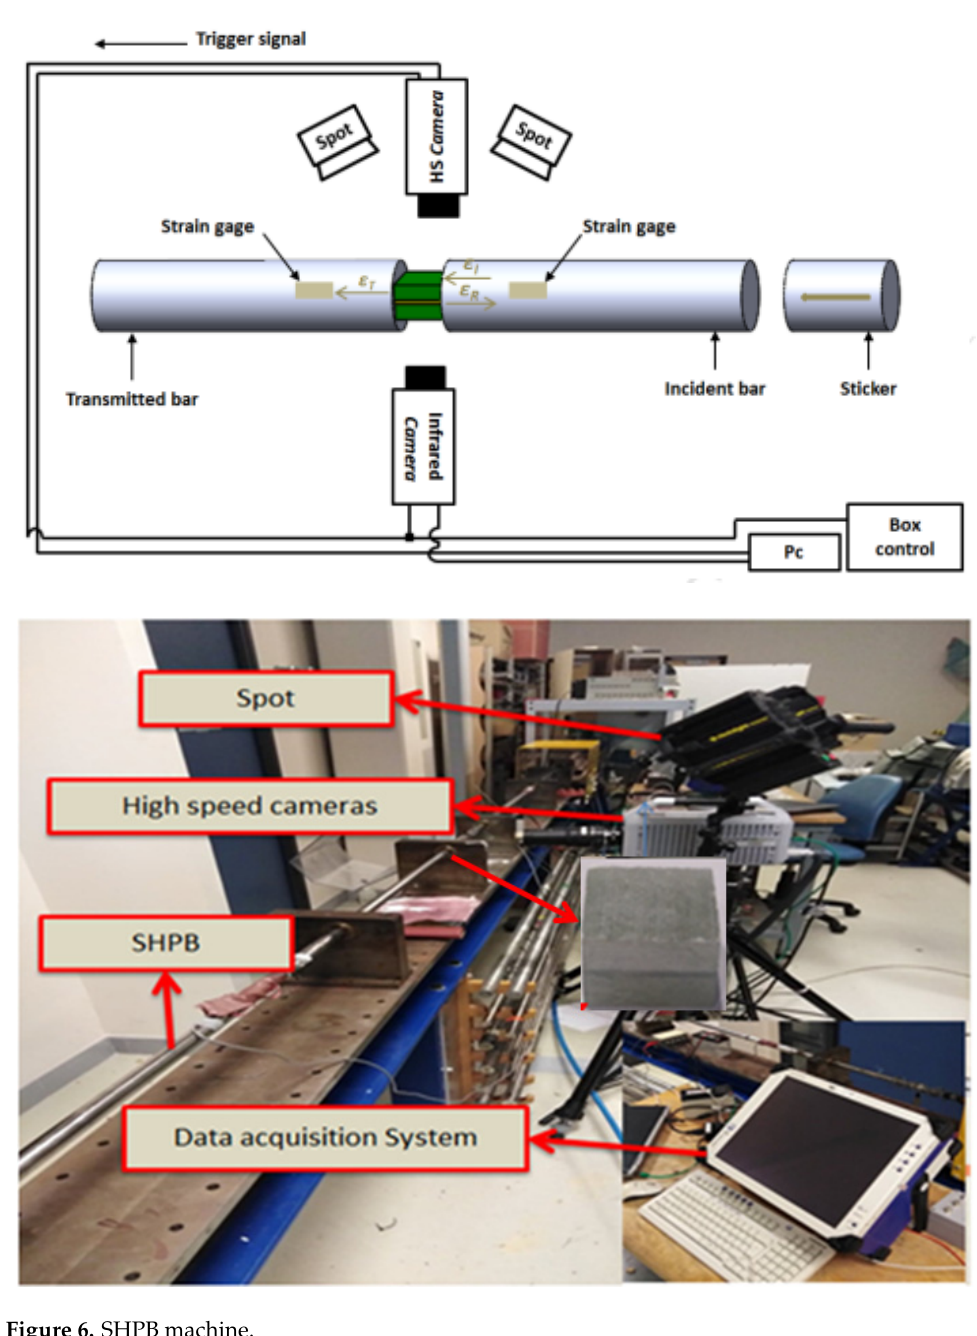
Figure 6. SHPB machine.